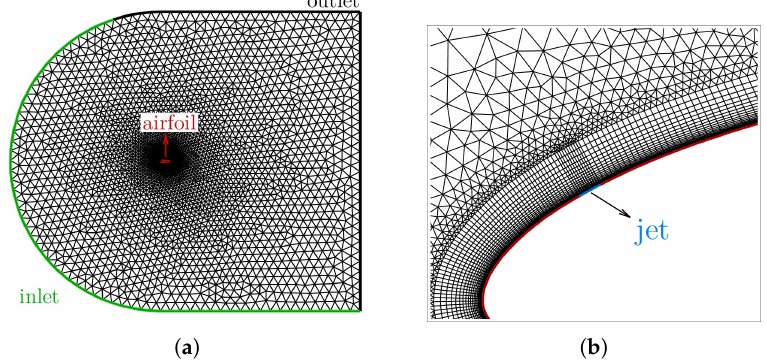
Figure 2. Full mesh of the domain ( a ) and Mesh nearby the Synthetic Jet actuator ( b ).